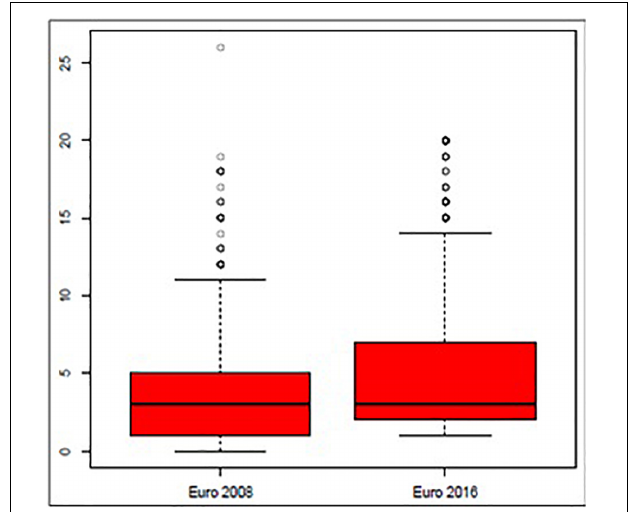
zone compared to the 2008 Euro edition. This circumstance may be due to a better management of the technical, tactical and physical player resources, since according to different works (Tenga et al., 2010a,b; Lago et al., 2012), the optimal zone of ball recovery is in the offensive midfield, especially in regions near the rival goal (Barreira et al., 2014a).